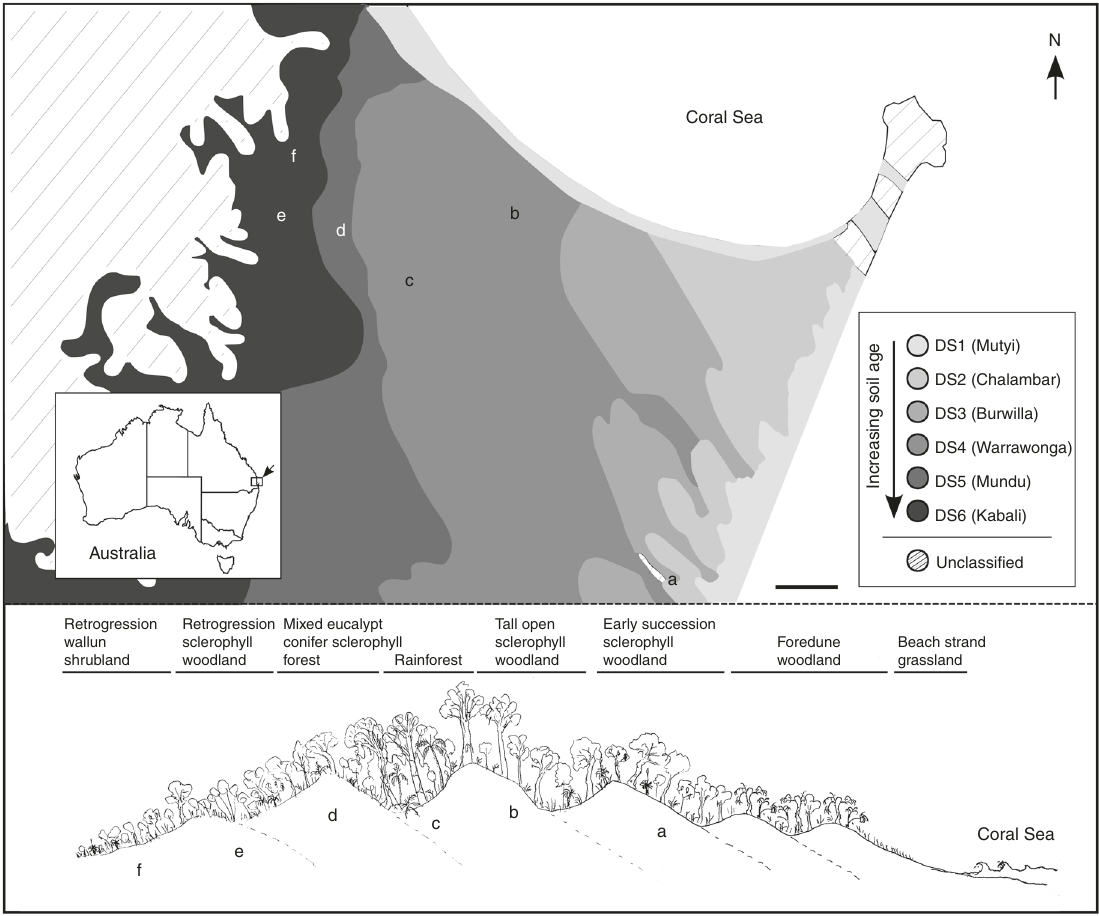
Fig. 1 Overview of Cooloola study site. Geographical location of the six plant communities sampled (sites a – f) in the Great Sandy National Park at Cooloola, Queensland, Australia, in relation to dune systems and vegetation types. Site a, open sclerophyll Eucalyptus racemosa early successional woodland; site b, Eucalyptus pilularis tall open moist sclerophyll forest; site c, rainforest (complex notophyll vine forest) with Agathis robusta , Ficus , and Archontophoenix cunninghamiana in fi re-sheltered parabolic high dunes; site d, mixed eucalypt conifer open sclerophyll forest with Eucalyptus racemosa , Angophora leiocarpa , and Callitris rhomboidea ; site e, retrogression sclerophyll shrubby woodland of Eucalyptus racemosa , Banksia aemula , and Leptospermum species; site f, retrogression Wallum shrubland with Banksia aemula , Xanthorrhoea johnsonii , and a high diversity of heath shrubs. Scale bar represents 1